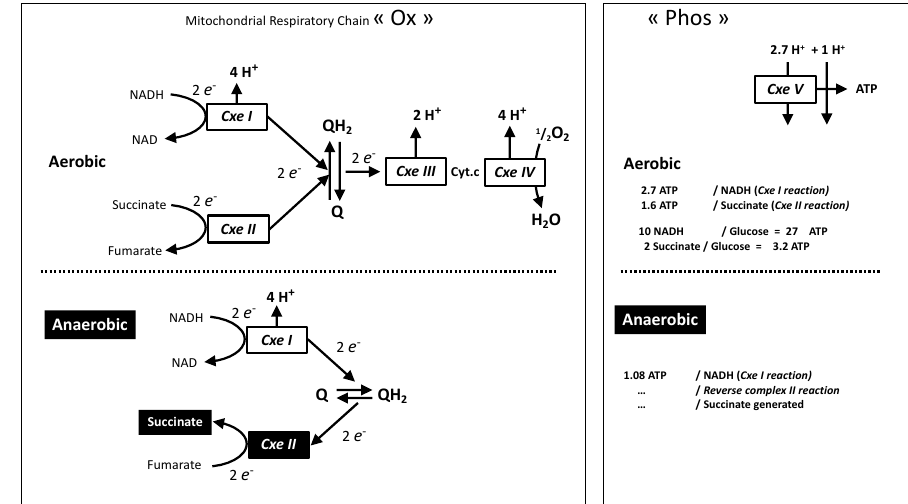
Figure 2. The oxidative phosphorylation machinery is split into “Ox”: complexes I - IV and “Phos”: complex V with ADP/ATP and Phosphate transporters (not shown). Redox intermediates in the respiratory chain are quinone (Q/QH2) and cytochrome c (Cyt.c). Stoichiometric relationship between proton movement and reactions catalyzed by the complexes are shown, this refers to the number of protons pumped per two electrons (Ox) or to proton-return reactions (Phos) required for generation of one cellular ATP by complex V and exchange of ions (ADP, ATP, Pi) between mitochondrial and cytosol. The aerobic situation “normal cellular bioenergetics” (top) is compared to the succinate generating anaerobic pathway (bottom).